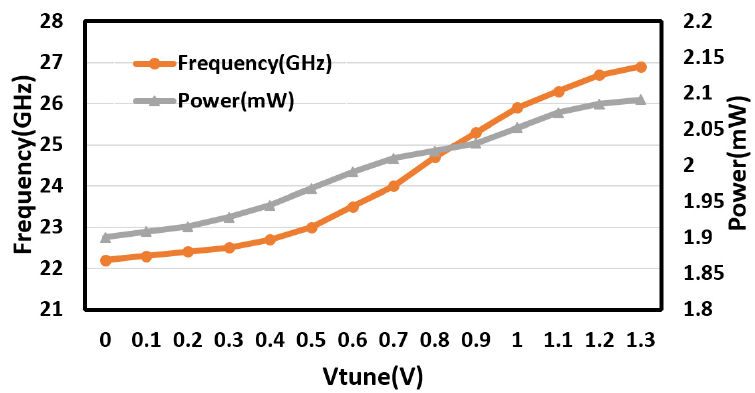
Figure 10. Operation frequency and power vs. tuning range.